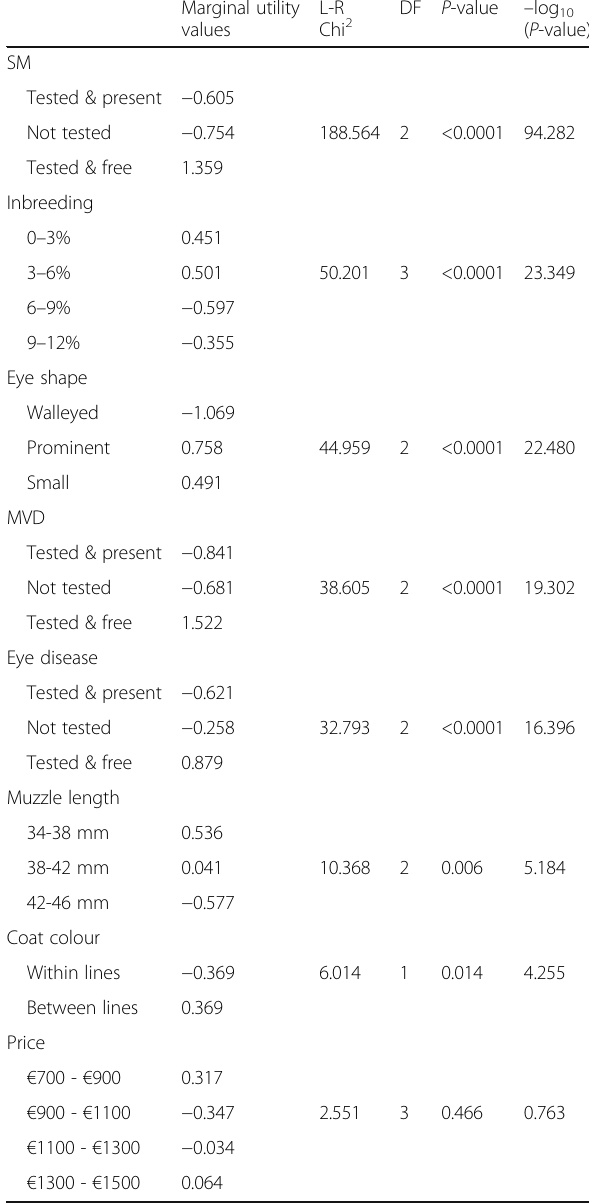
Table 3 Initial multinomial logit model results for each trait. Traits sorted in decreasing order of importance Marginal utility